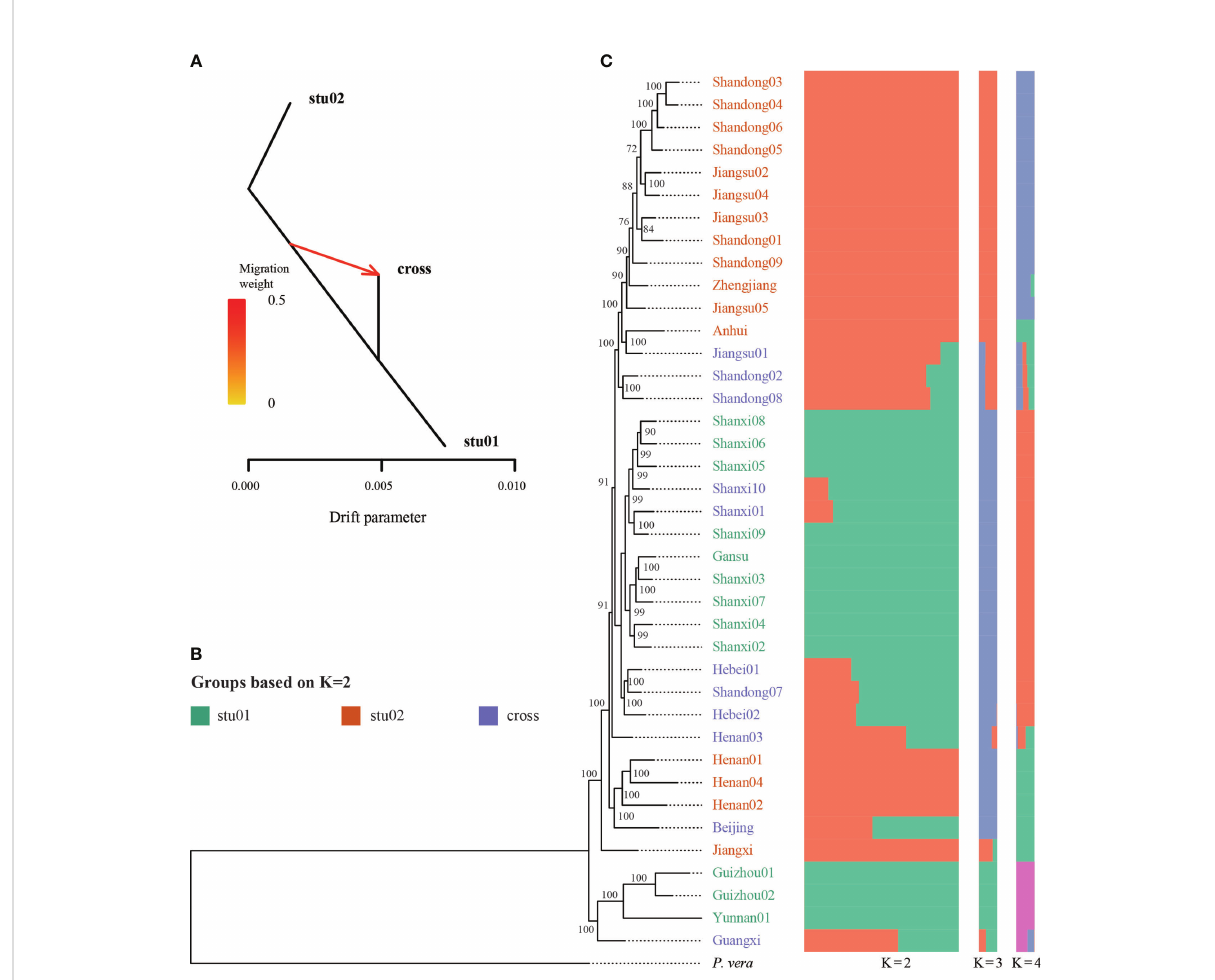
FIGURE 4 Genetic diversity of Pistacia chinensis based on nuclear SNPs. (A) Signal of introgression among different groups detected using the TreeMix program. According to the structure results (K = 2), we de fi ned three groups, stu01, stu02 and the crossed (hybrid) samples. (B) Phylogenetic tree. ML bootstrap support values are shown at each node. (C) Population structure analysis with K = 2, 3 and